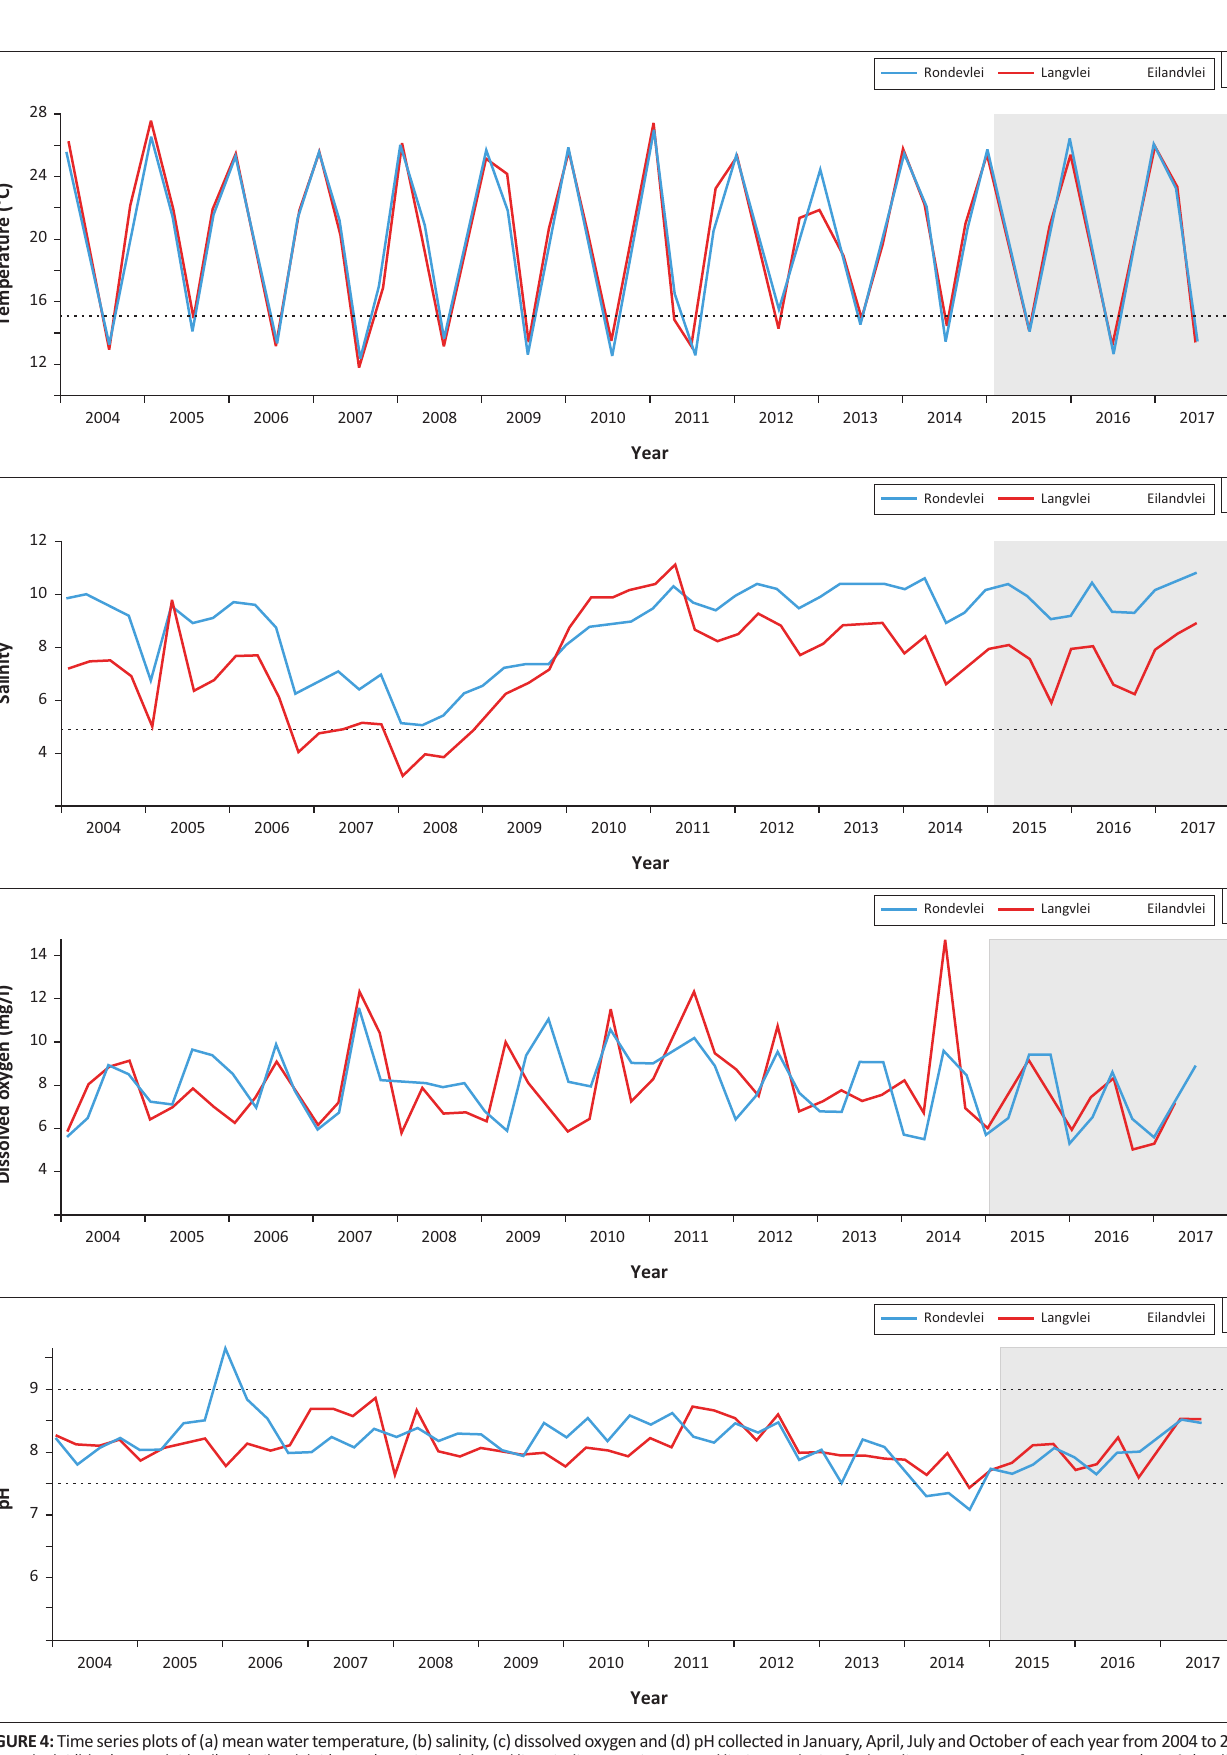
FIGURE 4: Time series plots of (a) mean water temperature, (b) salinity, (c) dissolved oxygen and (d) pH collected in January, April, July and October of each year from 2004 to 2017 in Rondevlei (blue), Langvlei (red) and Eilandvlei (green). Horizontal dotted lines indicate environmental limits conducive for botulism occurrence for temperature (> 15 °C), salinity (< 5) and pH (7.5 < pH < 9.0) (Rocke & Friend 1999). The shaded area indicates the period when botulism-related deaths of waterbirds were recorded in the Wilderness